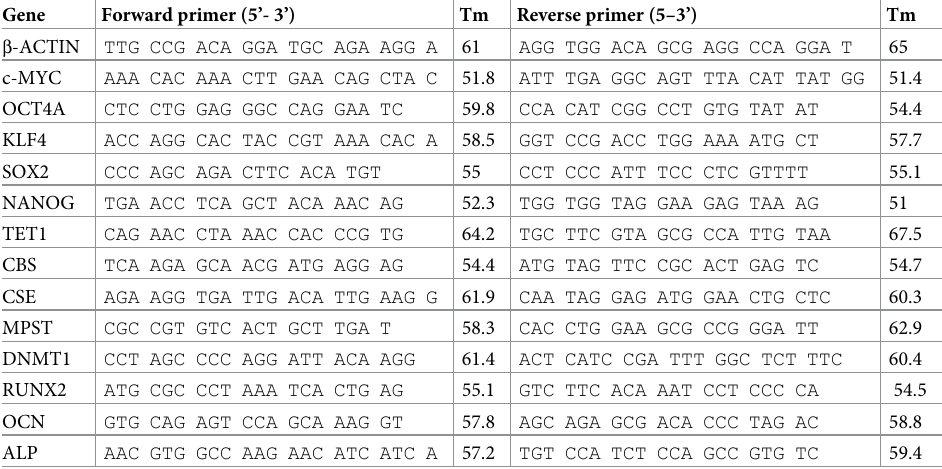
Table 1. Real-time qPCR